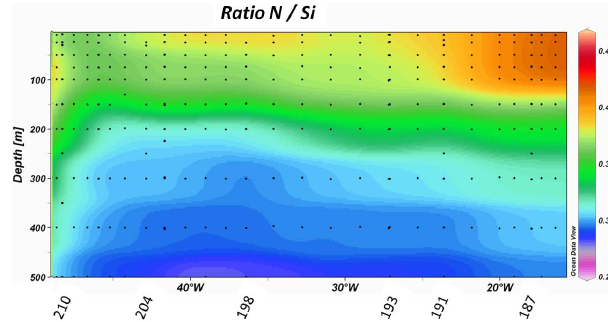
Fig. 8a. Section plot of N:P ratio along the Weddell Sea transect in the upper 500m, for that region where a winter water Layer is observed and a removal ratio is calculated ( ∼ 17– ∼ 48.5 ◦ W). The locations of the stations where DFe data is available and a nutrient removal is calculated are presented.